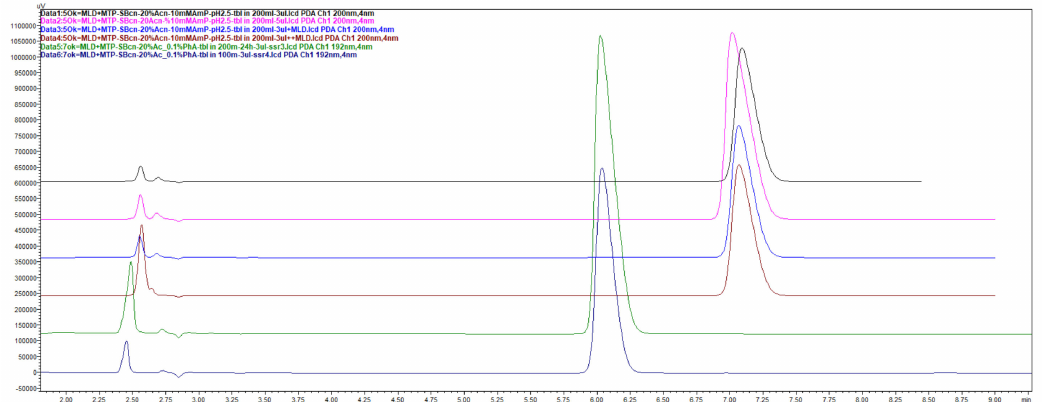
Figure 31. Chromatograms with Zorbax CN-SB-250 × 4.6 mm retention mapping of analytes as a function of eluate composition and pH, the overlay of mobile phase changes experiments for chromatogram shaping results, in trials with mobile phase composed of ACN,13 mM NH 4 H 2 PO 4 , and 0.08% v / v o-H 3 PO 4